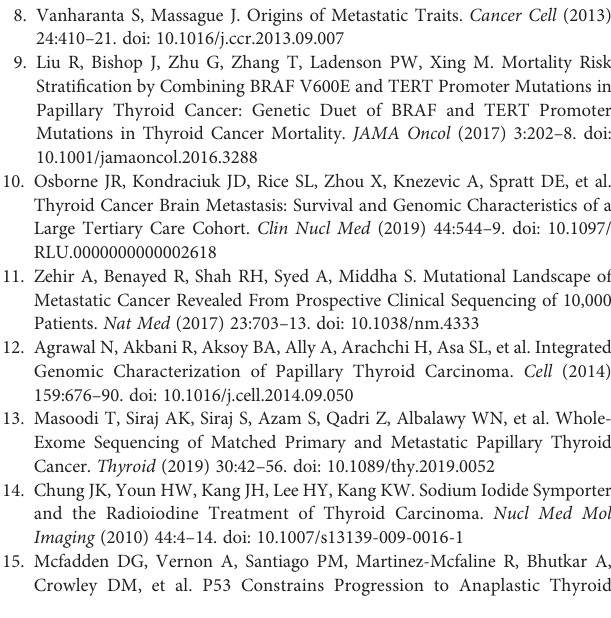
Supplementary Figure 1 | Flowchart of patients ’ inclusion/exclusion. Supplementary Figure 2 | Hematoxylin-eosin staining of each metastatic sample for determination of differentiation status. Supplementary Figure 3 | Sanger sequencing detection of BRAF , and TERT promoter. The black arrow indicated the hot spot of mutated BRAF and TERT promoter in previous reports. Supplementary Figure 4 | Illustration of WES-based SCNA. (A) SCNA landscape of each sample; (B) estimated foci SCNA. Supplementary Figure 5 | Construction of TP53 knockoutand CDK4/CDK4 R24C overexpression. (A) gRNA sequencing information and validation of TPC-1 monoclone with TP53 knockout; (B) construction of CDK4/CDK4 R24C overexpression plasmid; (C) evaluation of CDK4/CDK4 R24C overexpression in TPC-1 cells through